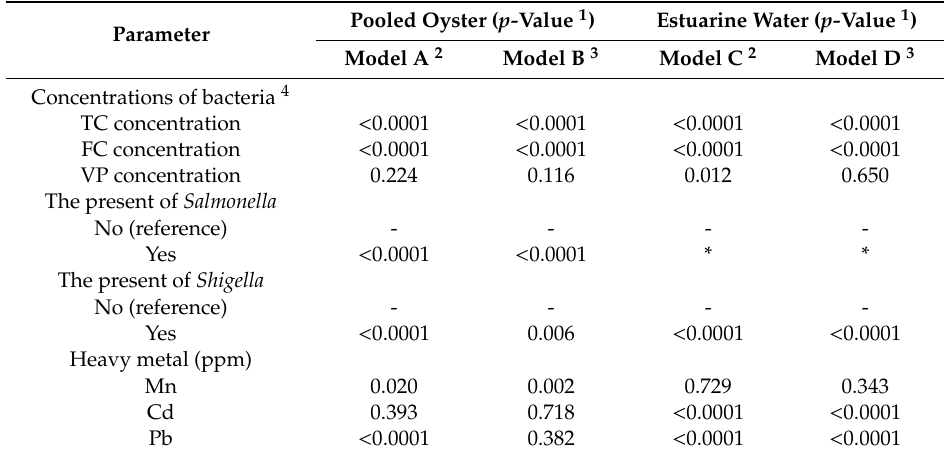
Table 2. Univariate analysis of the concentrations of E. coli for factors associated with bacterial and chemical contamination of pooled oysters and estuarine waters.